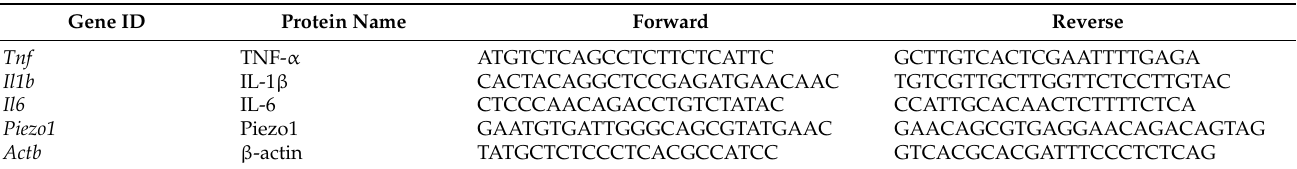
Table 1. Primers Sequences for